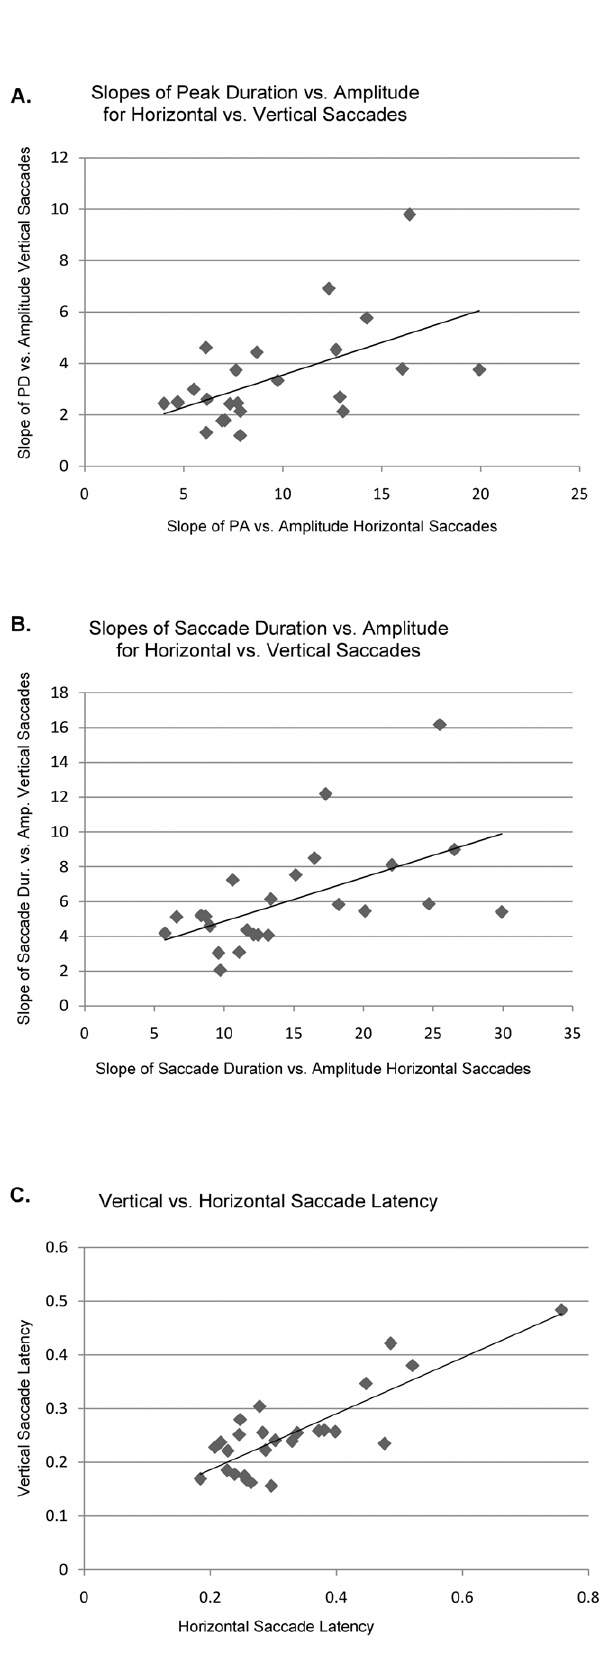
Figure 3. A. Slope of peak duration vs amplitude for vertical vs horizontal saccades. The line is a least squares regression of the data points and has an R 2 value of 0.3. This graph suggests there is a tendency for vertical and horizontal saccade performance to